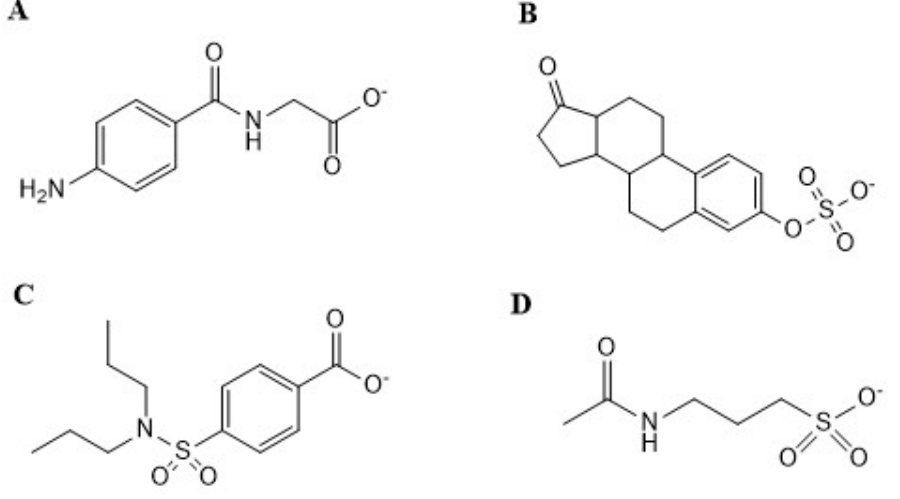
Figure 1. Chemical structures of ( A ) p -aminohippuric acid; ( B ) estrone-3-sulfate; ( C ) probenecid; ( D ) acamprosate (acetylhomotaurinate).